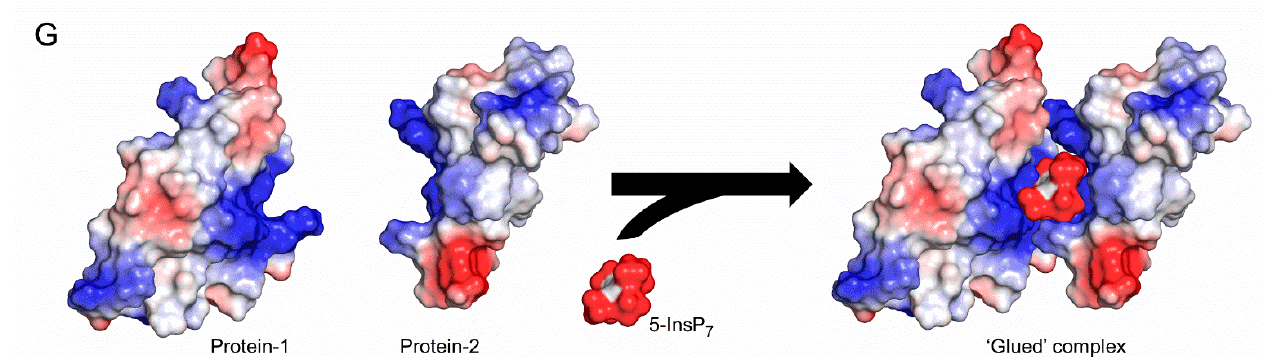
Figure 5. Direct pharmacological and molecular interventions in 5-InsP 7 synthesis modify nucleolar granular volume in HCT116 cells. ( A ) Schematic to illustrate the various experimental approaches performed with HCT116 cells in this dataset (clockwise from top left), the pharmacological inhibition of IP6K by TNP; siRNA knockdown of IP6K1 + 2 by siRNA; liposomal delivery of non-hydrolyzable 5-PCP-InsP 7 ; lentiviral-mediated stable expression of either wild-type IP6K2 or a Lys222Ala kinase-dead mutant (not shown in this graphic is the lentiviral co-expression of copGFP). ( B ) The copGFP fluorescence is shown in (clockwise from top left) non-transduced wild-type cells (‘Control’), or wild-type cells transduced with either lentiviral vector (‘Empty’), or vector hosting kinase-dead IP6K2 K222A , or the vector hosting catalytically active IP6K2 . The upper panels of each pair are stitched 20x fields of view; the top left corner of each upper panel (an individual field of view) is magnified 10-fold in each accompanying lower panel. Scale bars: yellow = 1 mm; red = 0.1 mm. ( C ) NSM volume in either non-transduced wild-type cells (‘Control’), or wild-type cells transduced with either lentiviral vector (‘Empty’), or vector hosting active IP6K2 , or vector hosting kinase dead IP6K2 K222A . ( D ) Effect of 10 µM TNP treatment (plus sign) or DMSO vehicle (minus sign) upon nucleolar volume in wild-type (white bars) or PPIP5K KO cells (gray bars). ( E ) The effect of siRNA against IP6K1/2 (noted with a plus sign) or corresponding controls (minus sign) upon NSM volume in wild-type (white bars) or PPIP5K KO cells (gray bars). ( F ) Effect upon NSM volume in wild-type cells after treatment with either empty liposomes or liposomes containing 5-PCP-InsP 7 . All data are mean values ± standard errors from three experiments. ** p < 0.01, *** p < 0.001. ( G ) A hypothetical electrostatic ‘glue’ to locally elevate protein concentration for promoting the formation of biomolecular condensates. Both 5-InsP 7 (drawn as a space-filling model) and proteins-1 and -2 are depicted as electrostatic surface plots with the intensity of blue and red coloration denoting the degree of positive and negative electrostatic potentials at physiological pH. Any similarity to real protein structures is purely coincidental.